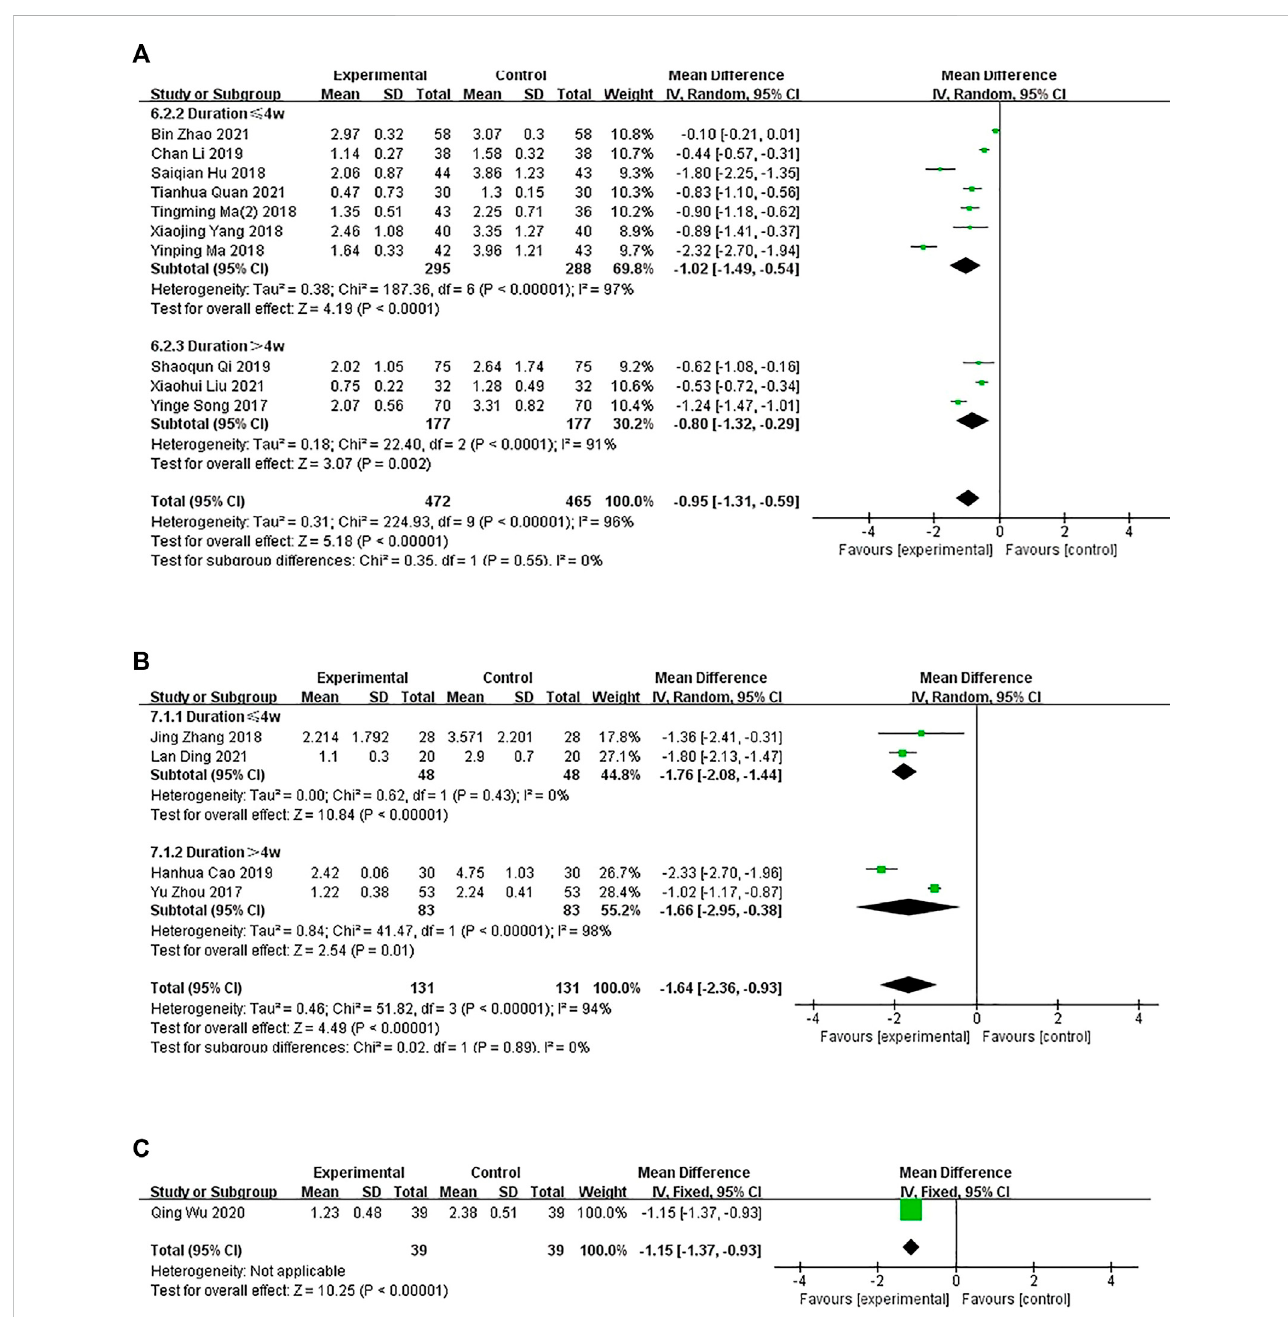
FIGURE 6 The results of the meta-analysis for the effect of the combination of Chinese herbal medicine and Western medicine versus Western medicine on pruritus. (A) Oral CHM treatment; (B) External treatment with CHM; (C) Oral and external treatment with CHM.